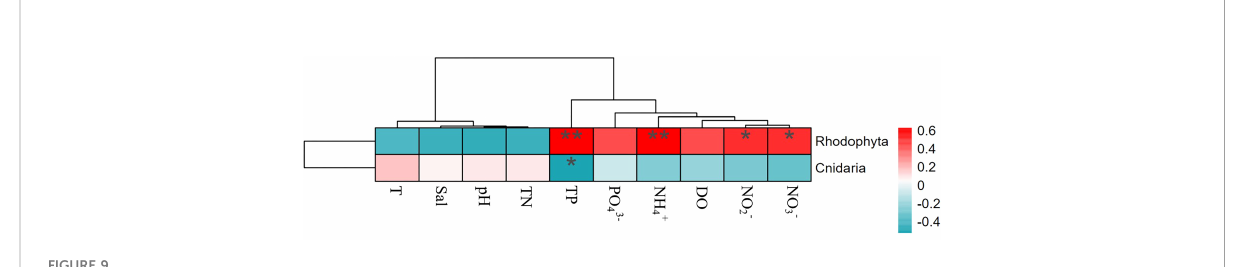
FIGURE 9 Correlation analysis between attached phyla and environmental factors (O-ARs). Colours represent positive and negative correlations (red represents positive correlation; blue represents negative correlation). Asterisks indicate signi fi cant correlations (** P < 0.01; and * P < 0.05). Environmental codes are as follows: temperature (T), salinity (Sal), dissolved oxygen (DO), active phosphate ( P − PO 3 − 4 ), nitrite ( N − NO − 2 ), nitrate ( N − NO